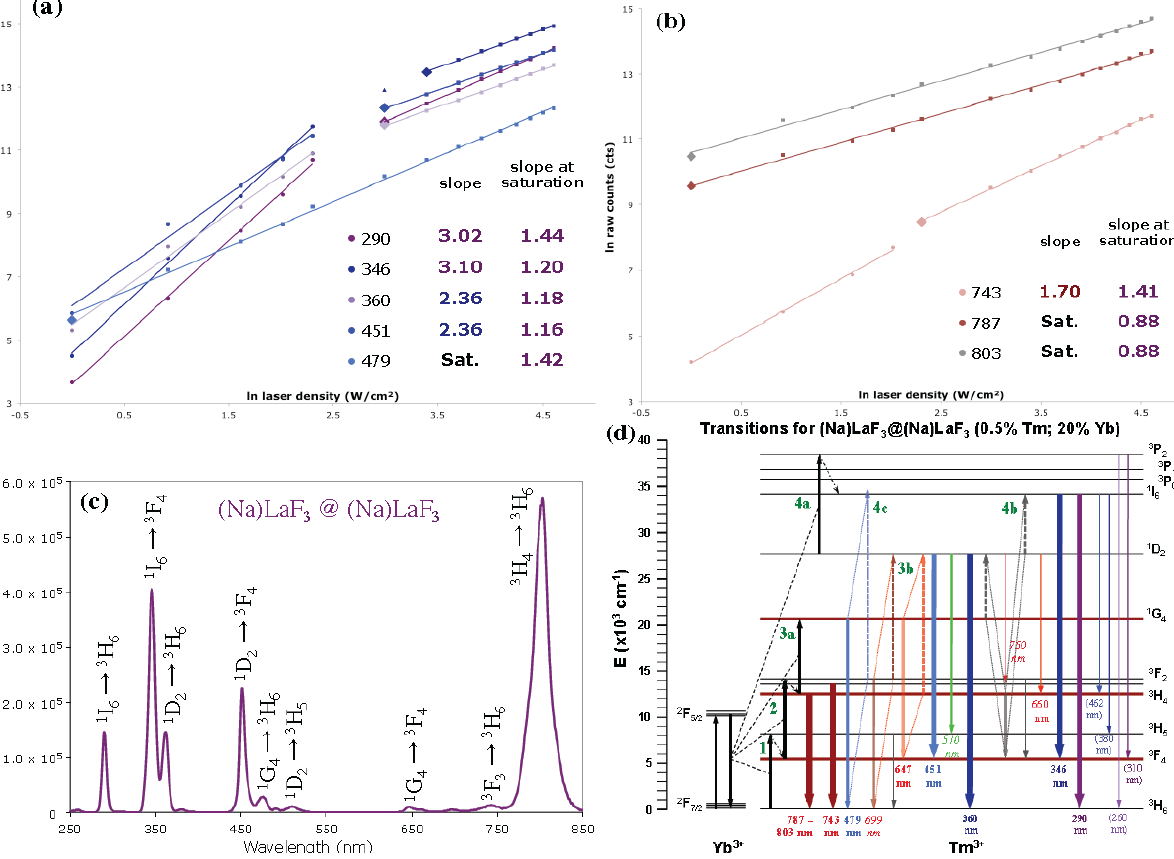
core@shell in the ( a ) UV/blue and 3 state and onset of saturation 4